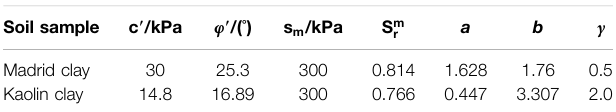
TABLE 1 | Model parameters of clays.